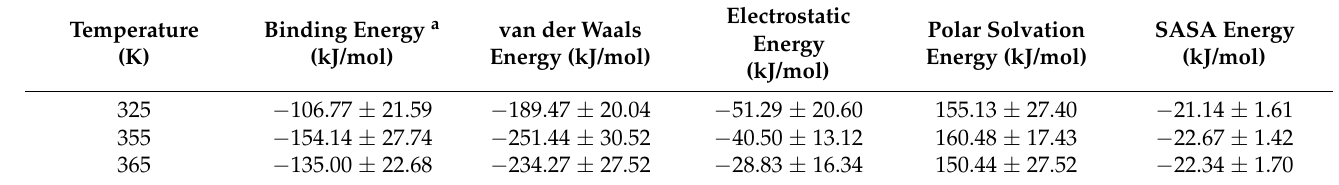
Figure 6. ( a ) In silico binding analysis of ABTS at the active site of rLAC and ( b ) the average distance variation between the C-atom of H497 and ABTS over 100 ns of the simulation at different temperatures. Table 2. The released binding energy of rLAC to the ligand